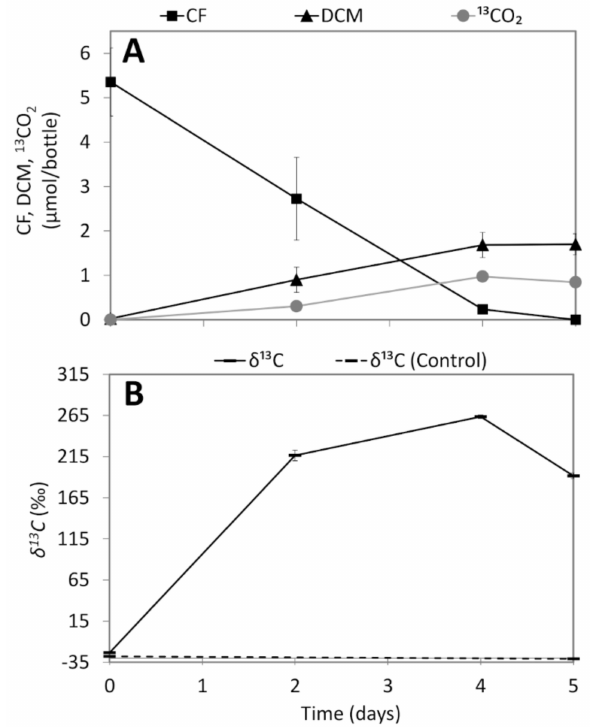
Figure 3. 13 CO 2 production from CF ( A ) and δ 13 C values ( B ) in the enrichment cultures amended with 1.25 µ mol / bottle 13 C-labelled CF, 3.75 µ mol / bottle non-labelled CF, and 4 µ M vitamin B 12 . Control cultures contained the same concentrations of non-labelled CF and vitamin B 12 . Points and error bars represent the average and standard deviation of samples taken from duplicate